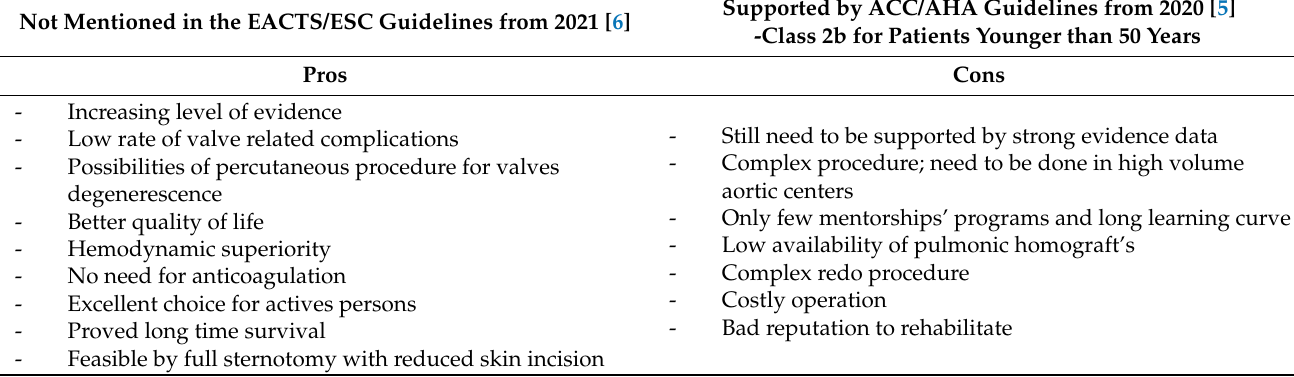
Table 1. Decision Making Algorithm. Ross Procedure for young patients.